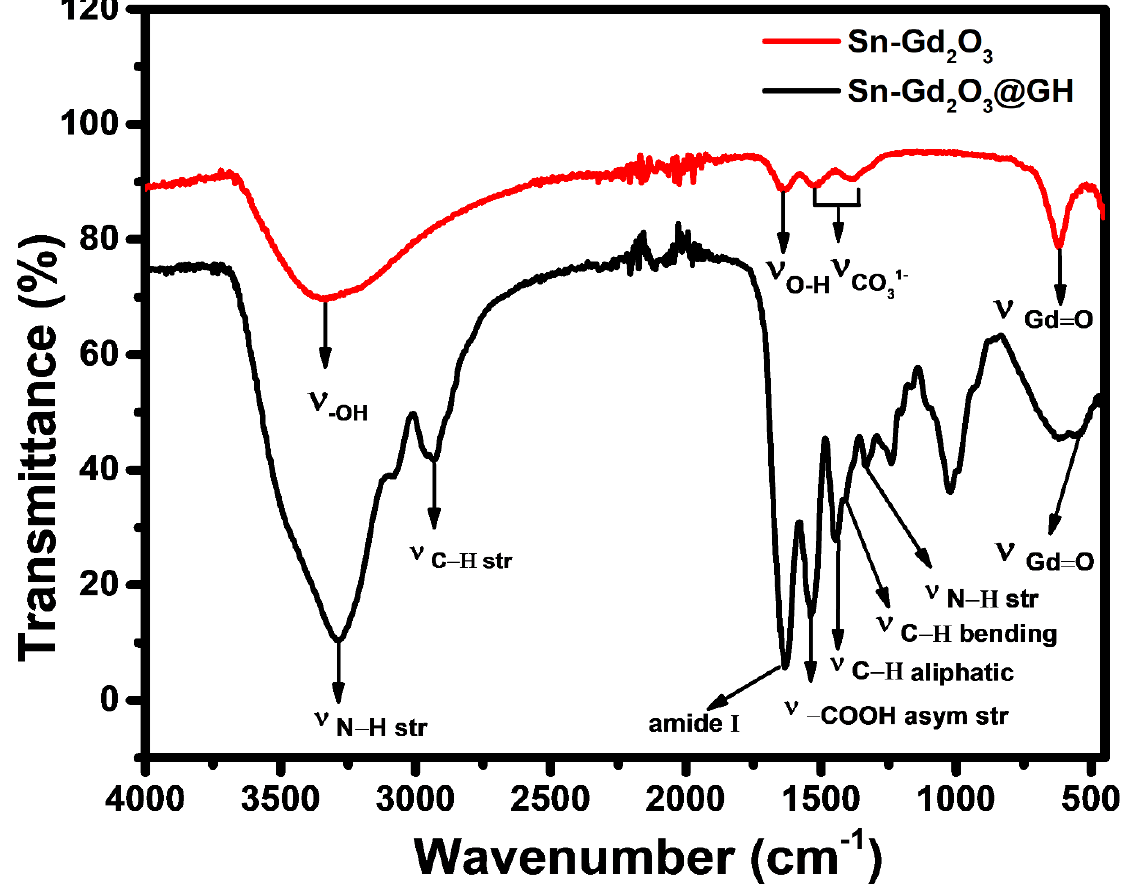
Figure 5. FTIR spectra of Sn-Gd 2 O 3 nanomaterial and Sn-Gd 2 O 3 @GH nanocomposite.